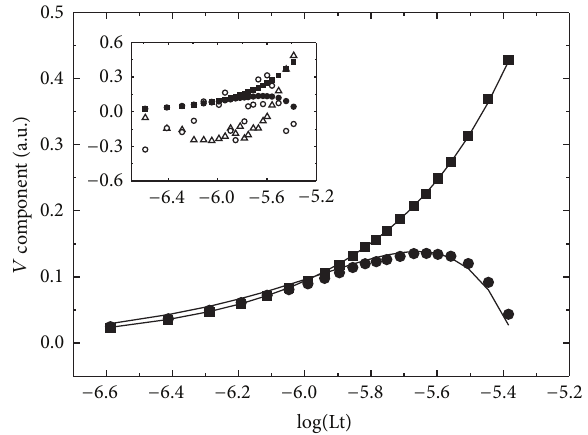
Figure 2: 𝑉 component amplitude as a function of the total ActD concentration. The symbols represent values, of the SVD matrix for the ActD-DNA titration. The squares represent the first 𝑉 component values and the circles represent the amplitudes of the second component. The first four 𝑉 component amplitudes are shown in the inset, and the results generated from F matrix were adjusted to the experimental data according to SVD analysis routine (solid lines).